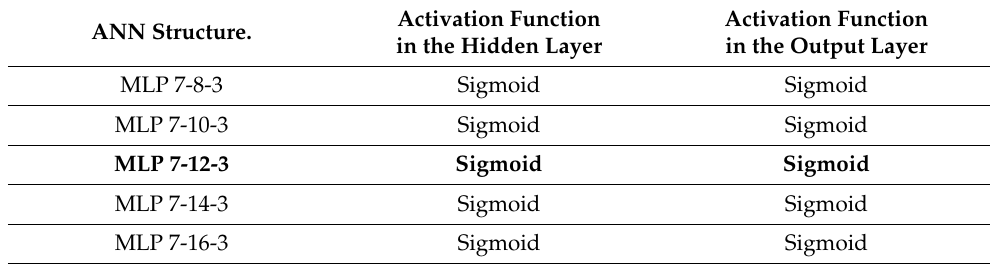
(Table 1): sigmoidal type–hyperbolic tangents as a very flexible nonlinear function. Table 1. The best MLP network models (the best one is marked in bold). Table 1. The best MLP network models (the best one is marked in bold). ANN Structure. Activation Function Activation Function ANN Structure. in the Hidden Layer in the Output Layer MLP 7-8-3 Sigmoid Sigmoid MLP 7-10-3 Sigmoid Sigmoid MLP 7-12-3 Sigmoid Sigmoid Sigmoid Sigmoid